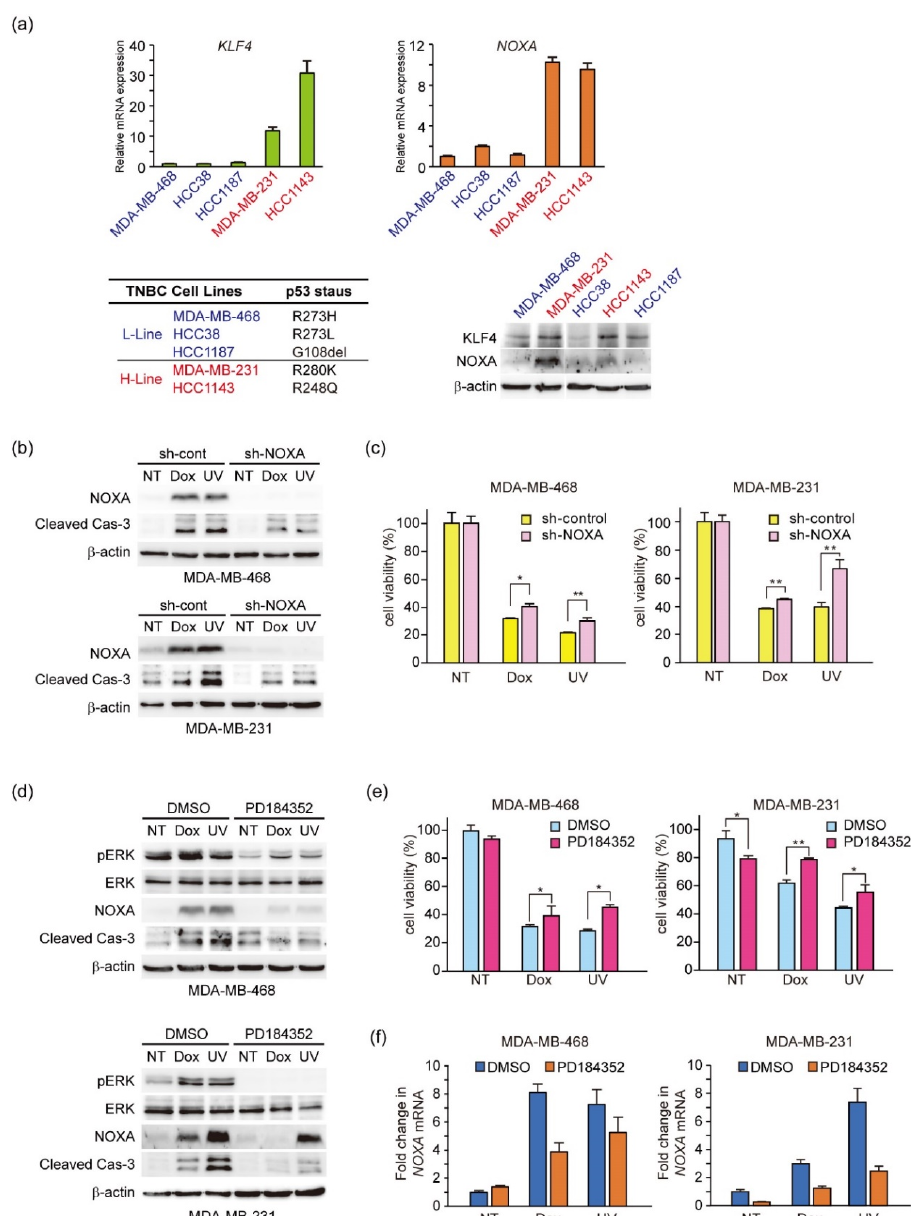
Figure 6. ERK activation and induction of NOXA by DNA damage-induced apoptosis in triple-negative breast cancer (TNBC) cells. ( a ) KLF4 (left, upper panel) and NOXA (right, upper panel) mRNA levels in the indicated cell lines were measured by qPCR. The mutation status of the p53 gene in TNBC cell lines is shown (left, lower panel). Total cell lysates (20 μg) were subjected to immunoblot analysis with the indicated antibodies (right, lower panel). Quantitative analysis of immunoblot results is shown in Supplementary Figure S4a. ( b , c ) TNBC cell lines (MDA-MB-468 and MDA-MB-231) that stably expressed shRNA-targeting NOXA (sh-NOXA) or sh-control were treated with doxorubicin (1 μg/mL) or irradiated with UV light (100 J/m2). After 24 h of treatment, 20 μg total cell lysates was subjected to immunoblot analysis with the indicated antibodies ( b ) and cell viability was measured by CCK-8 assays ( c ). Quantitative analysis of immunoblot results is shown in Supplementary Figure S4b. Error bars indicate S.E.M. ( n = 3). (* p < 0.05, ** p < 0.01, Welch’s t-test; n = 3) ( d – f ) TNBC cell lines (MDA-MB-468 and MDA-MB-231) were treated for 30 min with 5 μM PD184352 prior to doxorubicin (1 μg/mL) treatment or UV light (100 J/m 2 ) irradiation. After 24 h, the cells were analyzed by immunoblotting with the indicated antibodies ( d ), cell viability was measured by CCK-8 assays ( e ) and NOXA mRNA levels were measured by qPCR ( f ). Quantitative analysis of immunoblot results is shown in Supplementary Figure S4c. Error bars indicate S.E.M. ( n = 3). (* p < 0.05, ** p < 0.01, Welch’s t -test; n = 3).